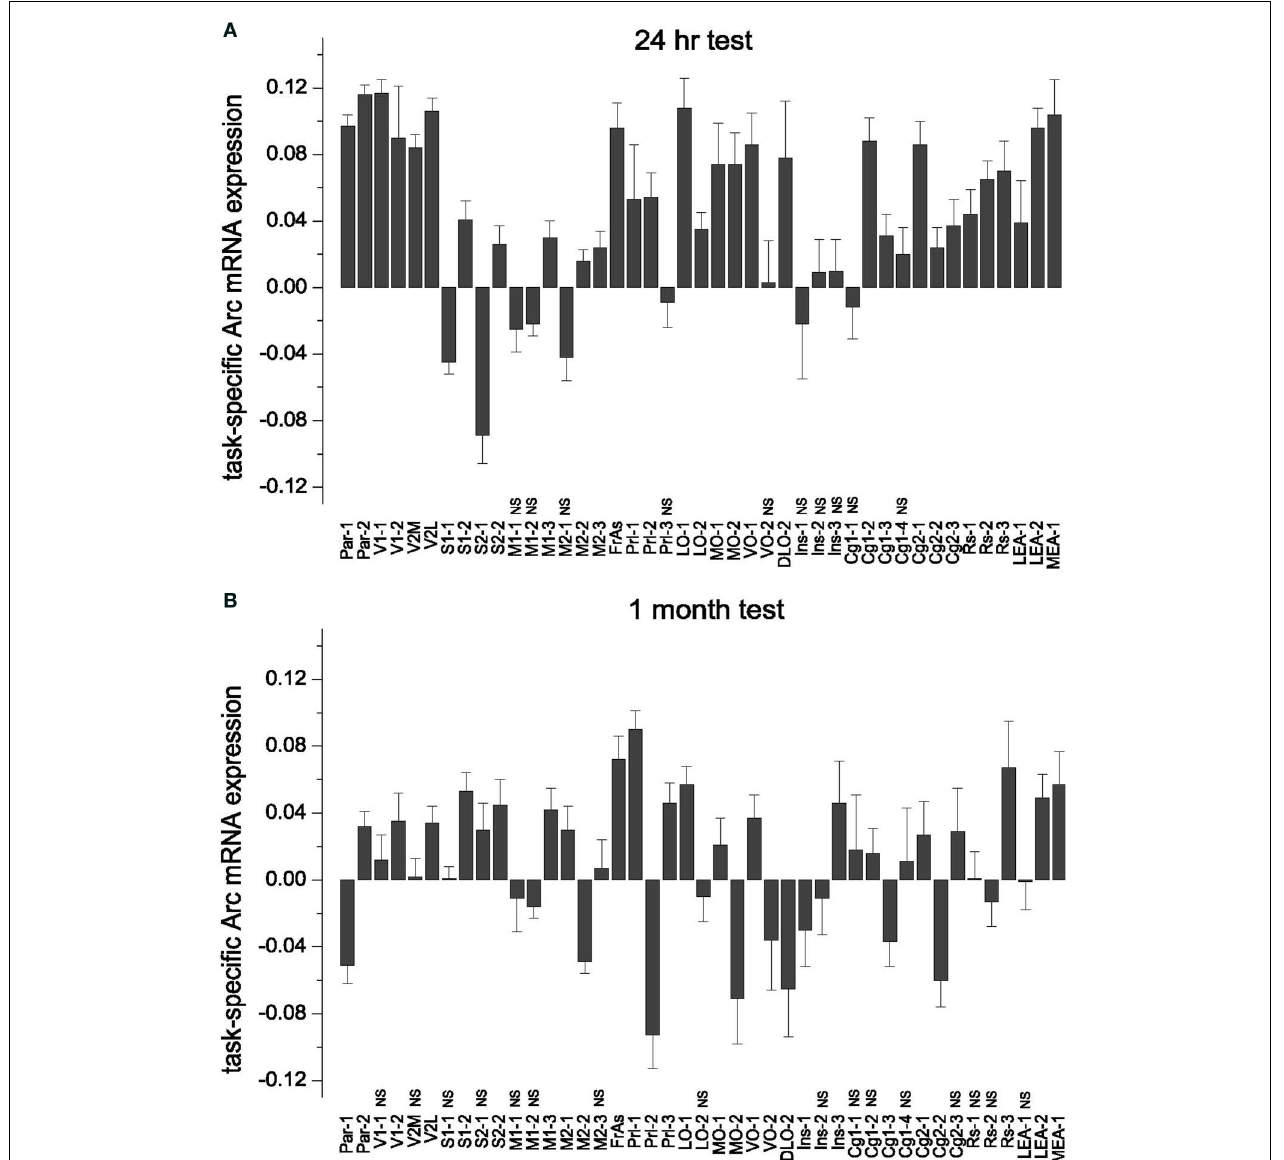
FIGURE 2 | Task-specifi c changes in overall (averaged across the all layers) Arc gene expression: subdivision of cortical areas, stereotypical magnitude of Arc expression increase and its area-specifi c persistence over 1-month memory consolidation. (A,B) Both during recent and remote memory activation, the post hoc analyses distinguished only cortical segments that had opposite changes in Arc expression, or the segments with and without changes in Arc expression. The latter segments had statistically non-signifi cant (NS) differences in Arc expression levels and indicated with NS. There was no difference in magnitude of learning-specifi c signals within the groups of cortical segments with more or less Arc gene expression compared to swimming controls. (A) There was no task-specifi c signal in M1-1, M1-2 and M2-1, Prl-3, VO-2, Ins-1, Ins-2 and Ins-3, Cg1-1, Cg1-4 ( Table S1A in Supplementary